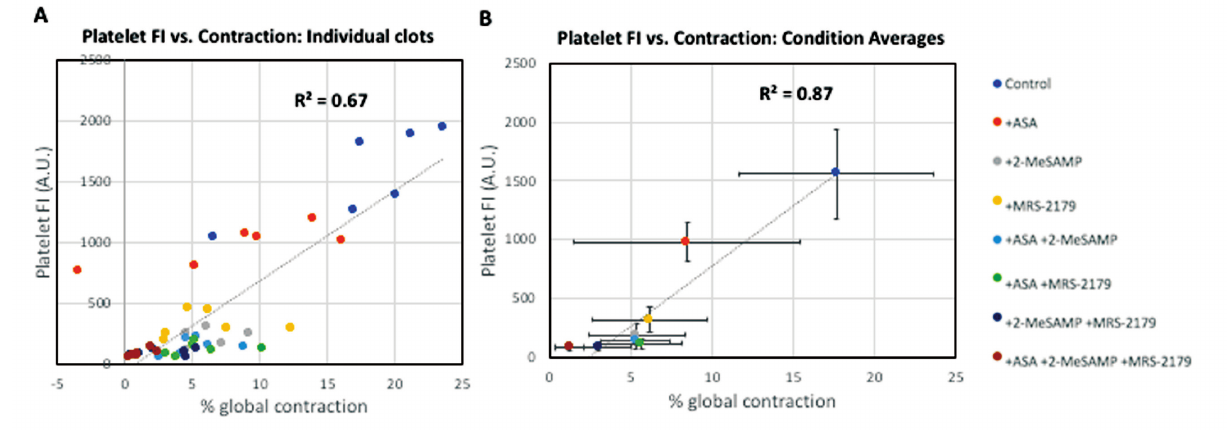
Fig. 4 Platelet fl uorescence correlates with global contraction. Final platelet fl uorescence and % global contraction were graphed for individual clots (A) . Average fl uorescence and contraction values for each condition were also graphed (B) . (N ¼ 3 donors, n ¼ 6 clots for B; AU ¼ arbitrary units). FI, fl uorescence intensity.